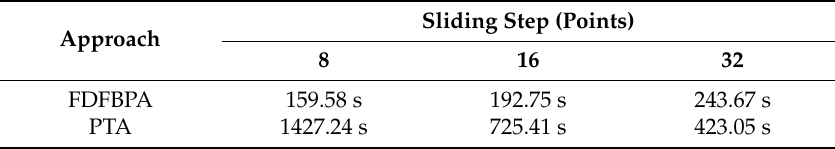
Table 5. Computation time comparison of FDFBPA and PTA under different sliding